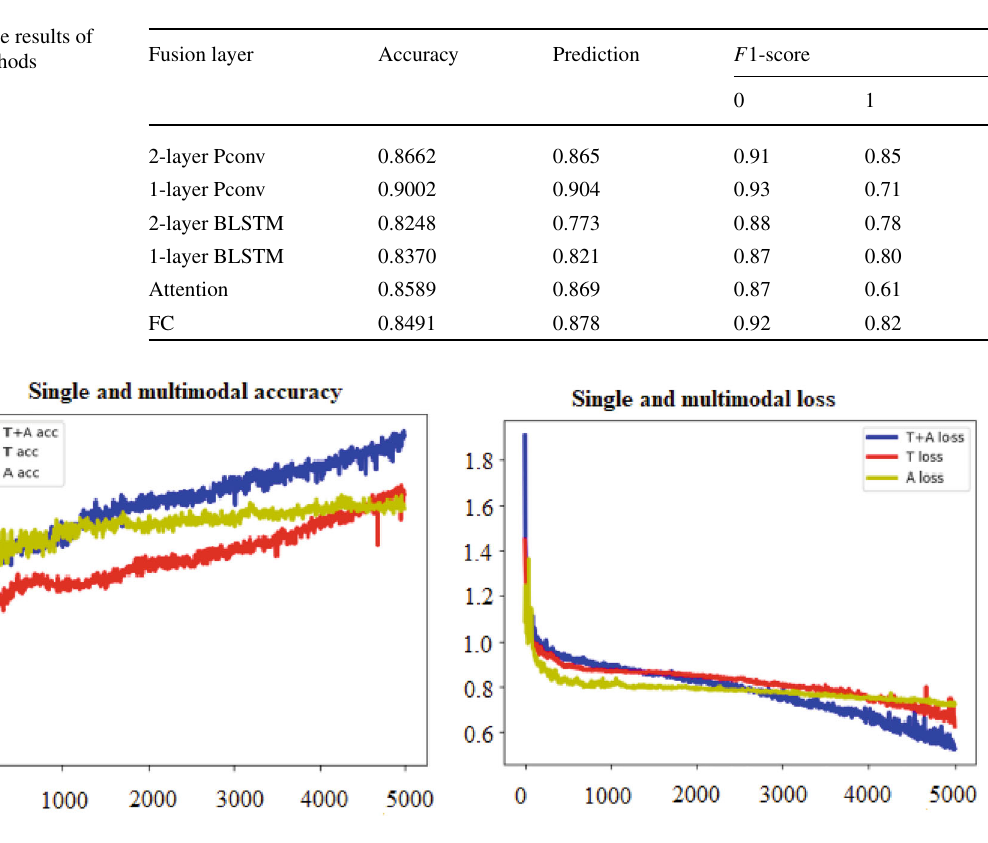
Fig. 7 Comparison of accuracy and loss between the fusion model and single